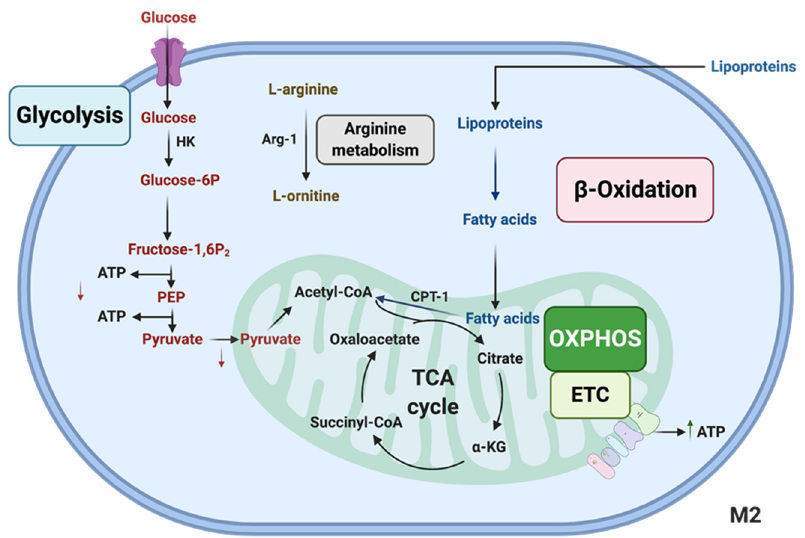
Figure 4. Important metabolic pathways in M2 Macs . M2 Macs have increased ATP production through electron transport chain (ETC) oxidative phosphorylation (OXPHOS). M2 Macs show lower levels of glycolysis, increased levels of fatty acid oxidation ( β -Oxidation) and increased arginine